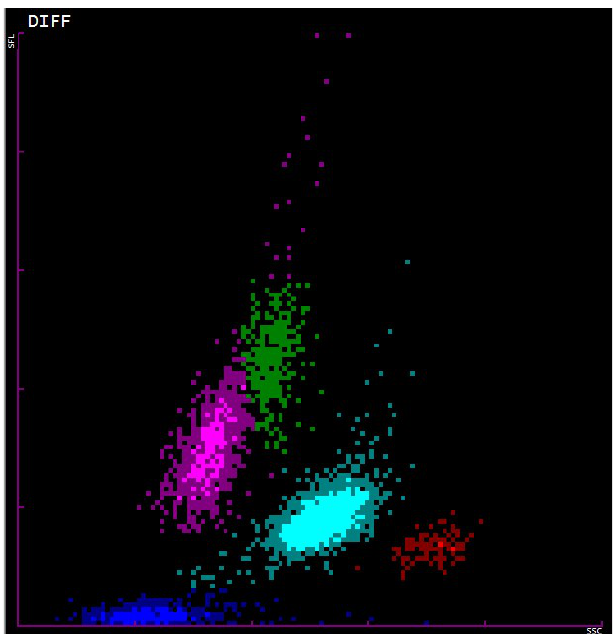
Figure 1 . Representative scatterplot showing the pattern of white blood cells in a peripheral blood smear. The pink plot represents lymphocytes, green represents monocytes, light blue represents neutrophils, red represents eosinophils, and red represents red blood cells.